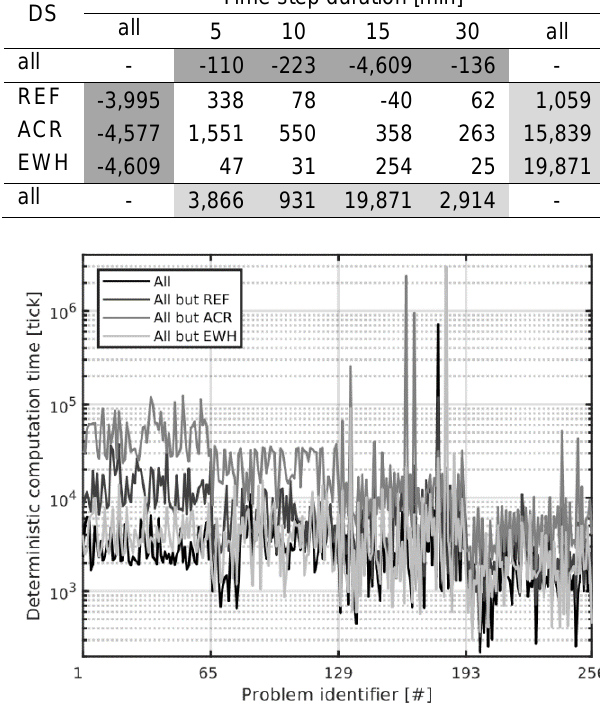
Figure 9. DCT (y-axis) for each scenario (z-axis) on the use of SVs, for each basic problem (x-axis) [problems # 1-64, 65-128, 129-192, 193-256 are those for time step durations of 5, 10, 15 and 30 minutes,